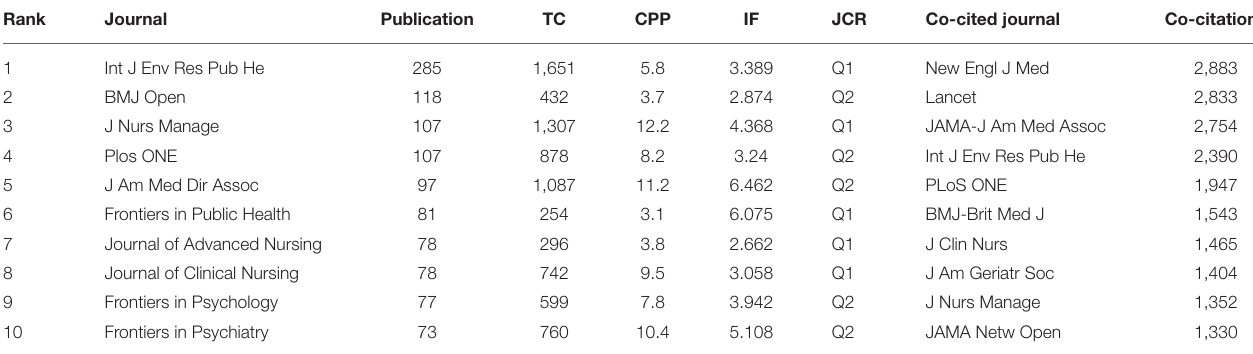
TABLE 3 | The top 10 prolific journals and co-cited journals.